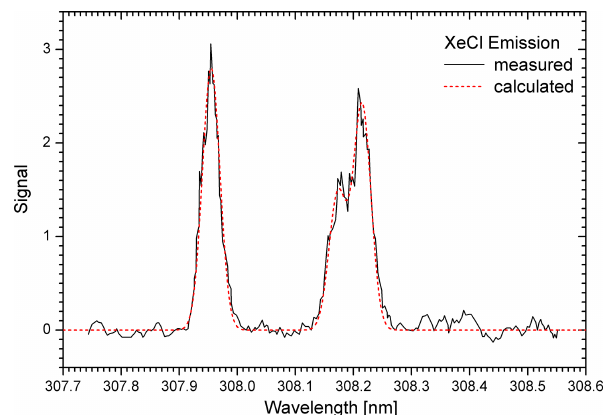
Figure 3. Emission spectrum of a Coherent high-power XeCl laser in broadband operation (source: Coherent); the dashed red curve is the sum of three Gaussian lines with centres at 308.955, 308.173 and 308.215nm and a full width at half maximum of 0.0357nm.